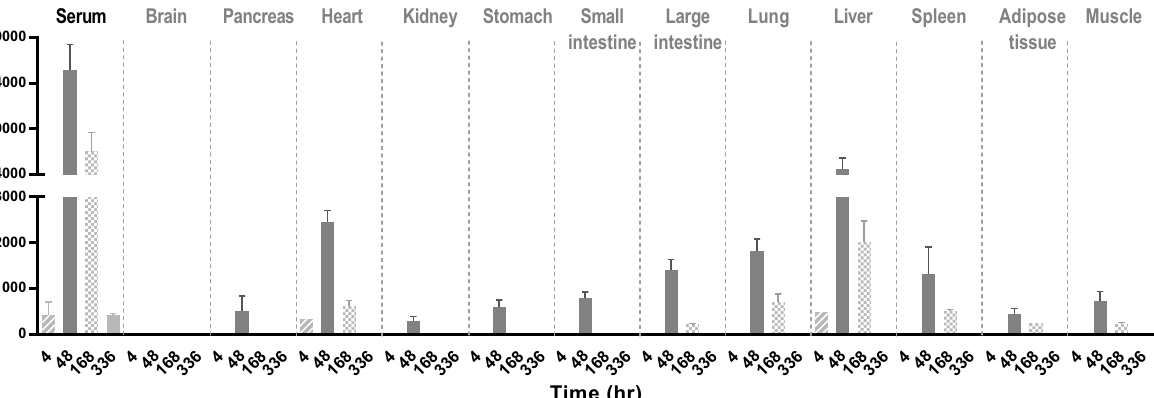
Figure 6. High levels of HM15136 were observed in the liver where gluconeogenesis and glycogenolyis occur. Concentration (ng/mL for serum or ng/g for tissue) and T/S ratio